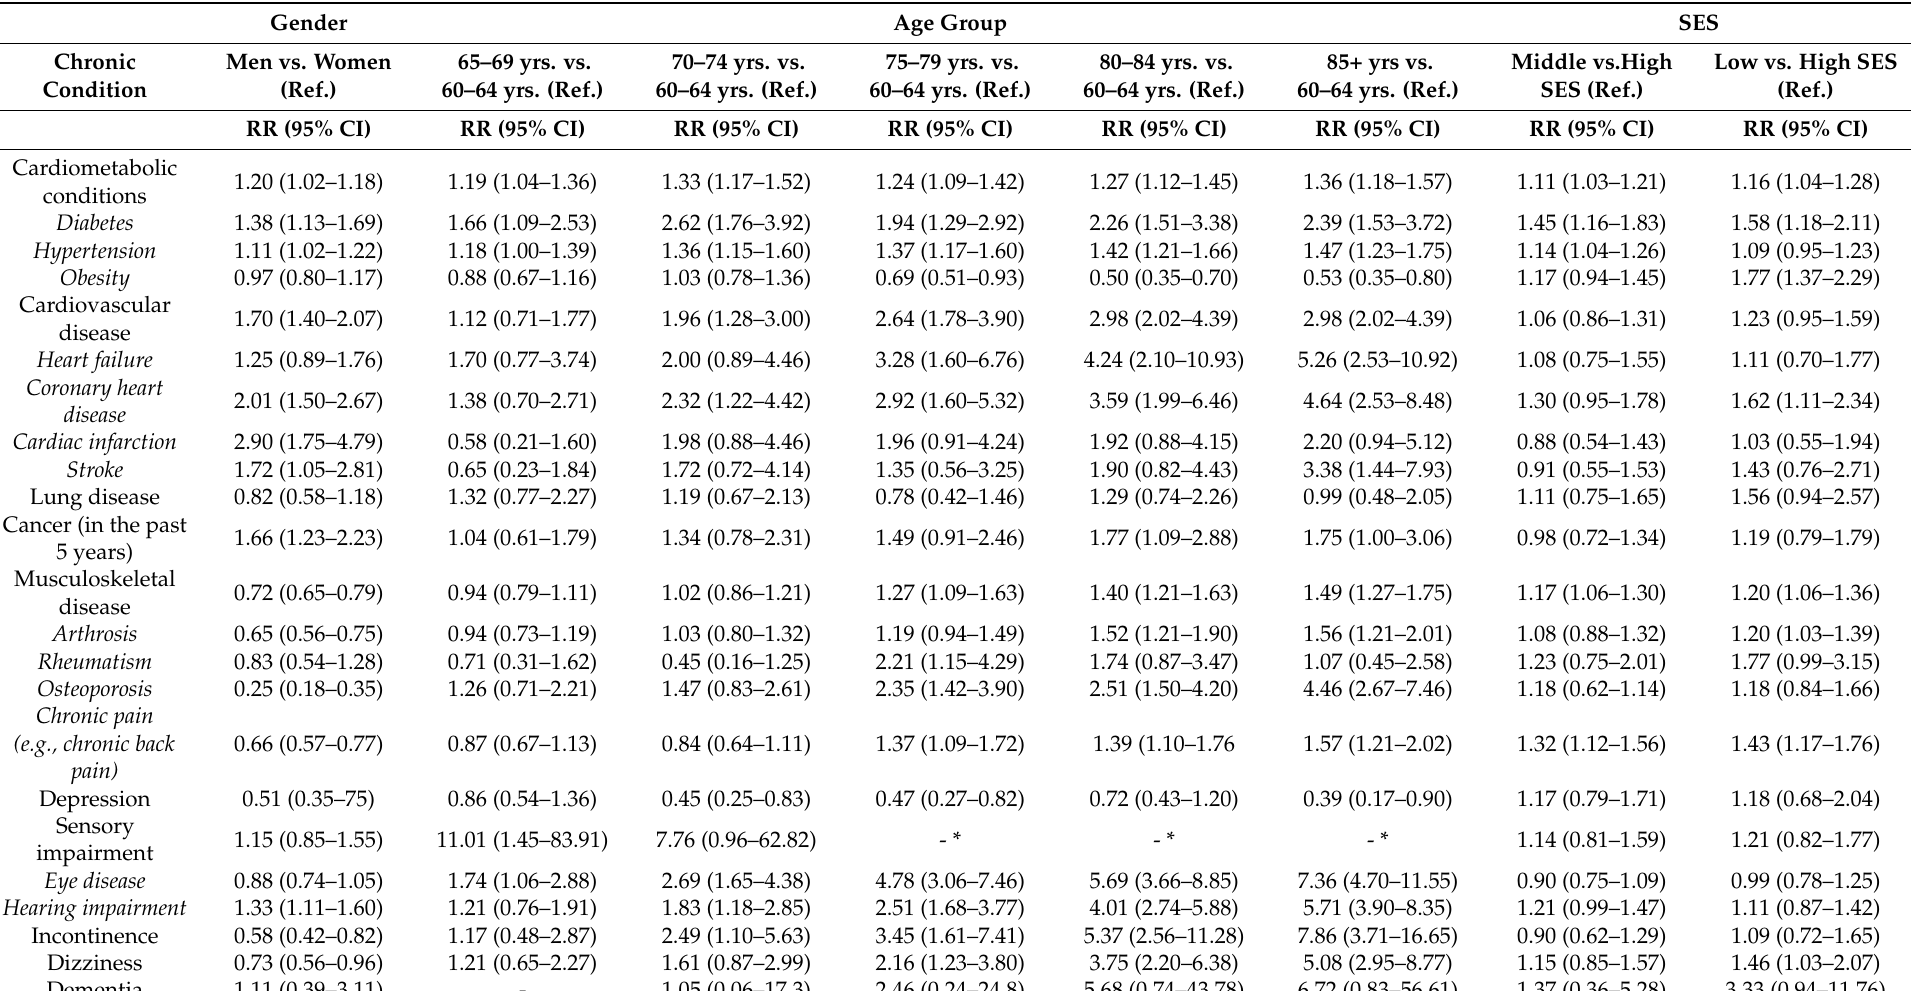
Table 4. Risk of self-reported chronic conditions from Poisson regression, adjusted for gender, age, and socioeconomic status